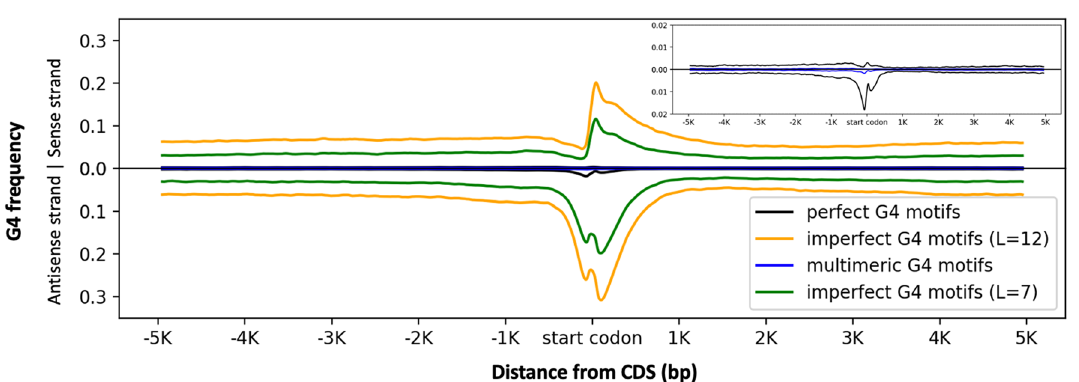
Figure 4. G4 frequency distribution of different G4 motifs over the 10 kb region centered at the high- confidence gene start site. X-axis represents the location with respect to start codon. Y-axis represents the G4 frequency which was calculated by the average number of G4 motifs at each position per Mb. Represented motifs are perfect G4 motifs (black), multimeric perfect motifs (blue), imperfect G4 motifs (green), and imperfect G4 motifs with long loops (orange). A focused plot on the top right corner shows the G4 motif distribution for the G4 frequency smaller than bulge up to 2 bases. Overall, total number of imperfect G4 motifs (5,884,180) were ~ 18 times higher than the perfect G4 motifs. In general, perfect and imperfect G4 motifs showed similar distributions, where ~ 5% of the both perfect and imperfect G4 motifs were located within 500 bp flanking regions of the high-confidence bar- ley genes. The enrichment patterns were varied between imperfect and perfect G4 motifs: imperfect G4 motifs peaked at (1) upstream and (2) downstream of the start codon on the antisense strand, and (3) the downstream of the start codon on the sense strand (Fig. 4).